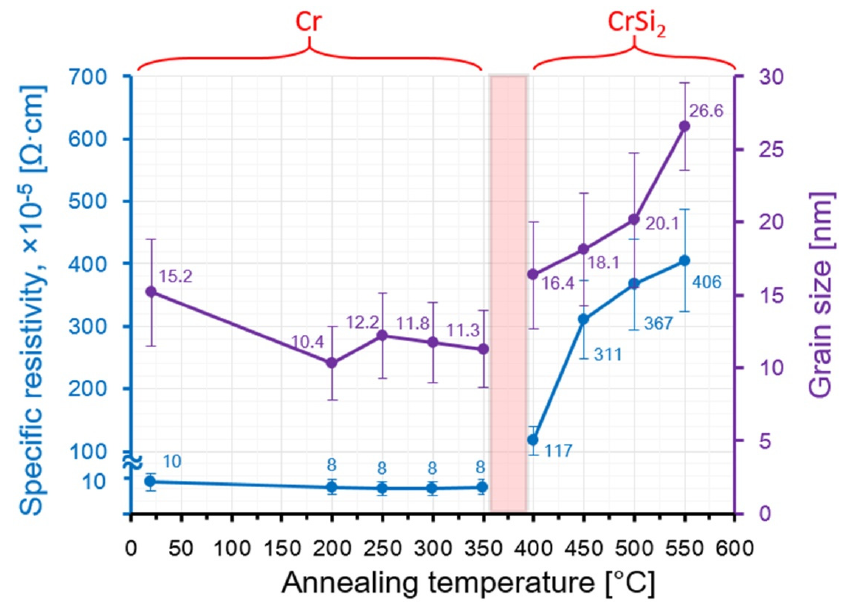
Figure 7. Dependences of resistivity and the mean grain size in the Cr film on the temperature of the rapid thermal treatment of the Cr/Si structure. rapid thermal treatment of the Cr/Si